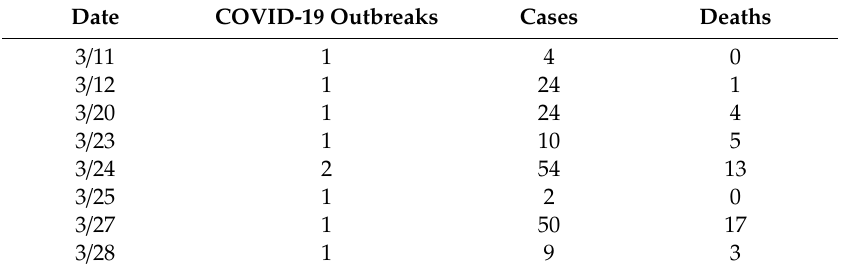
Table 3. Number of COVID-19 outbreaks with cases and deaths in Colorado from March 11, 2020 to